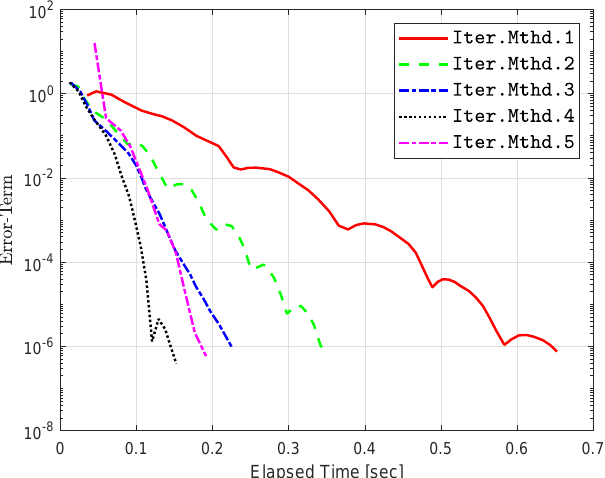
Figure 12. All techniques are computationally examined while s 0 = ( 2, − 1,3,2,5 ) T